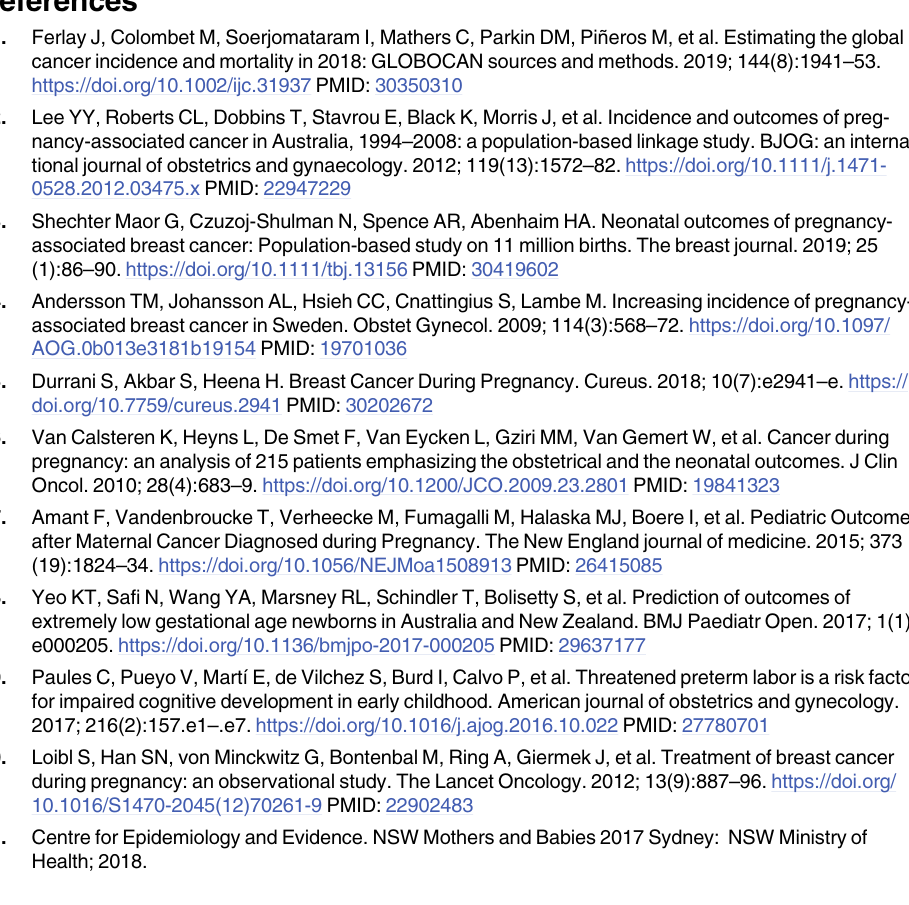
S5 Table. Regression models of Table